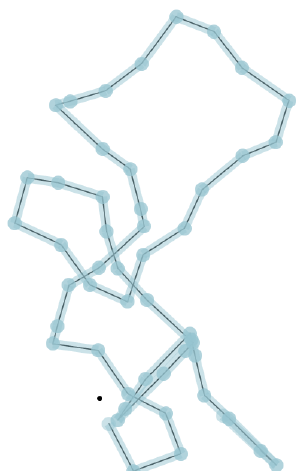
Figure 10. Trajectory obtained with s x ,0 = 0.2, s y ,0 = − 0.54, b = − 0.92, d = 0.002, δ = 0.075 and (cid:101) δ = 0.1, for the dimensions of the rectangular regions and disks respectively. The real trajectory is contained inside the region determined by the sequence of rectangles and disks. Therefore, the characteristic lengths δ and (cid:101) δ give an estimate of the precision involved in the